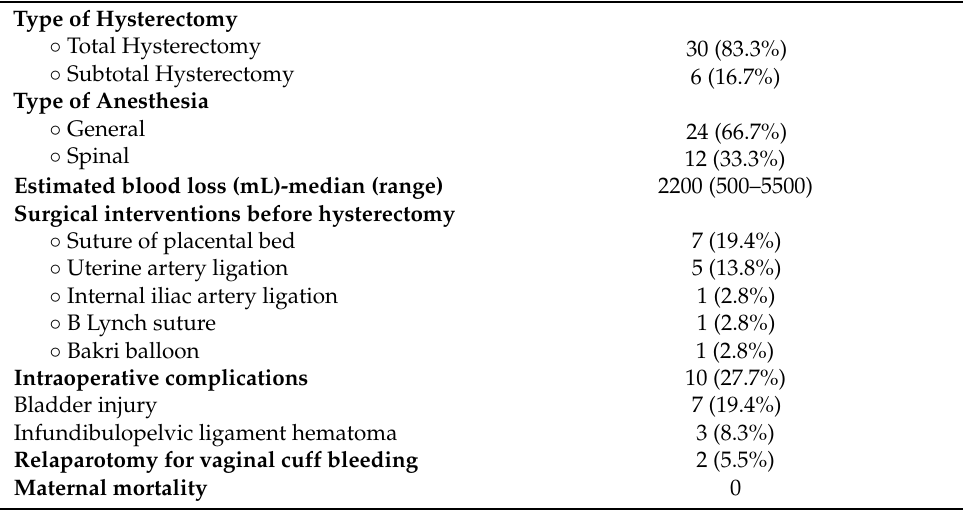
Table 3. Parameters related to peripartum hysterectomy in the 36